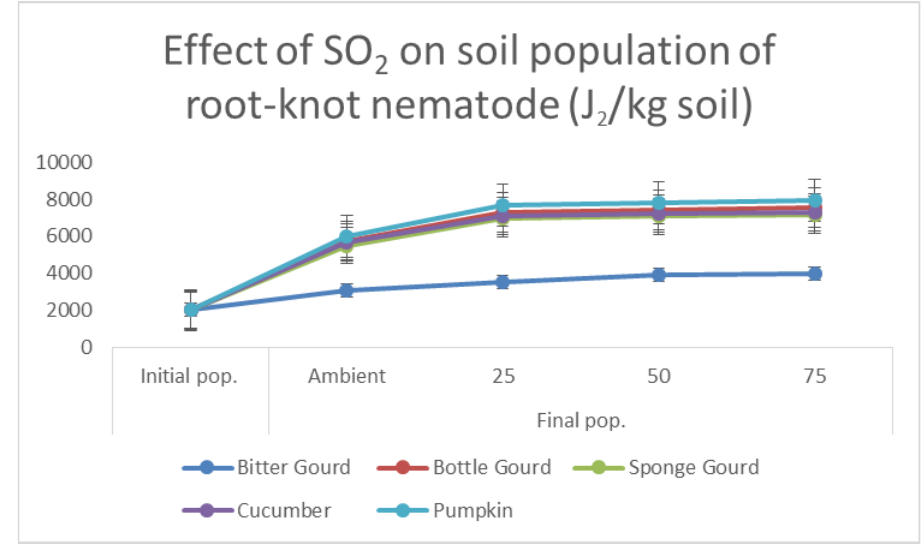
Figure 3. Line diagram, showing the effect of SO 2 exposure on soil population of root-knot nematode, in five